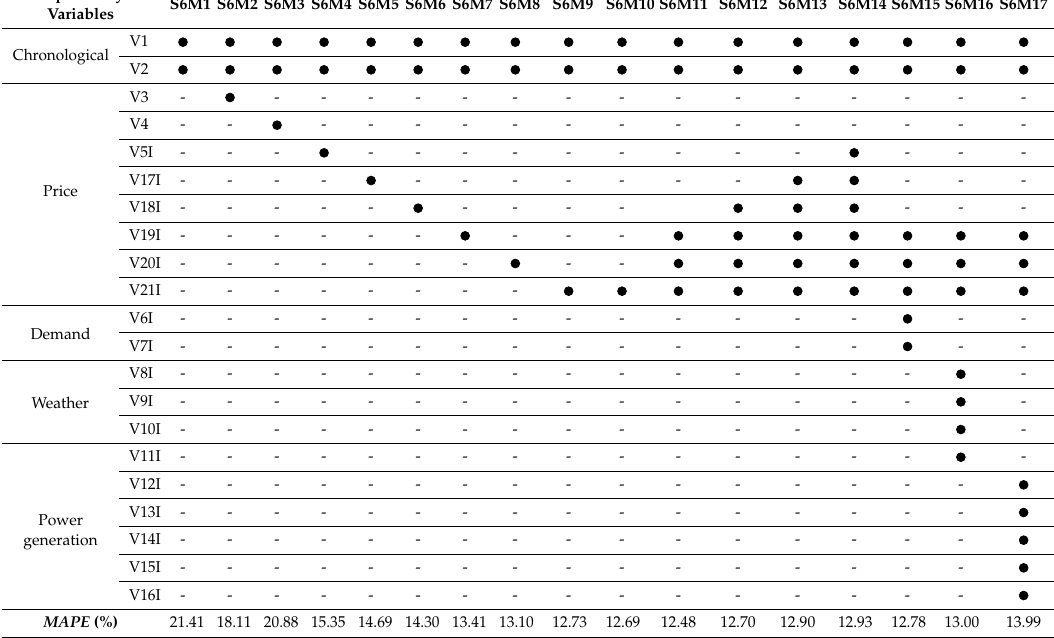
Table 13. ISMPF models for intraday session 6 and their MAPEs .